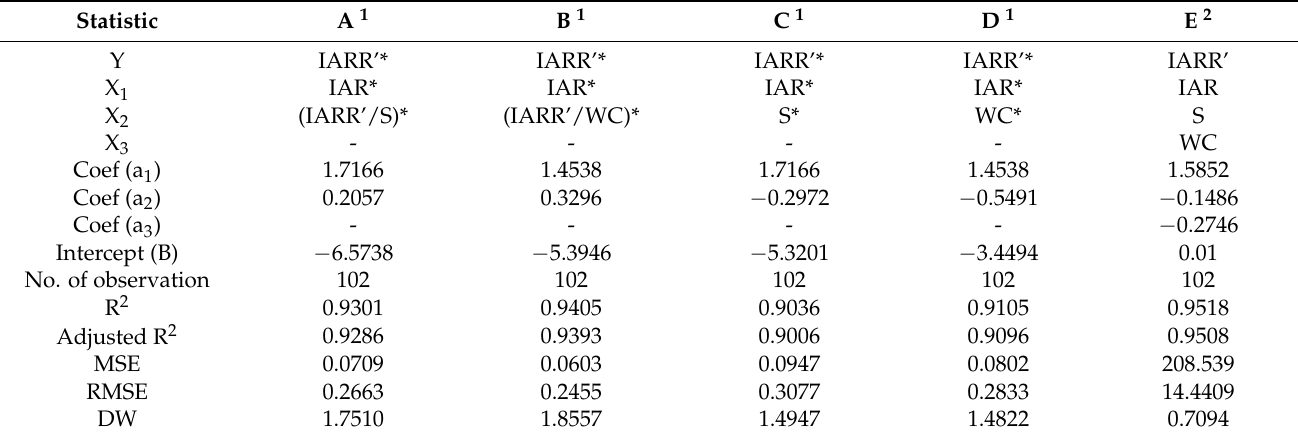
Table 4. Statistical parameters and performance tests of multiple regression models, obtained by ANN 1